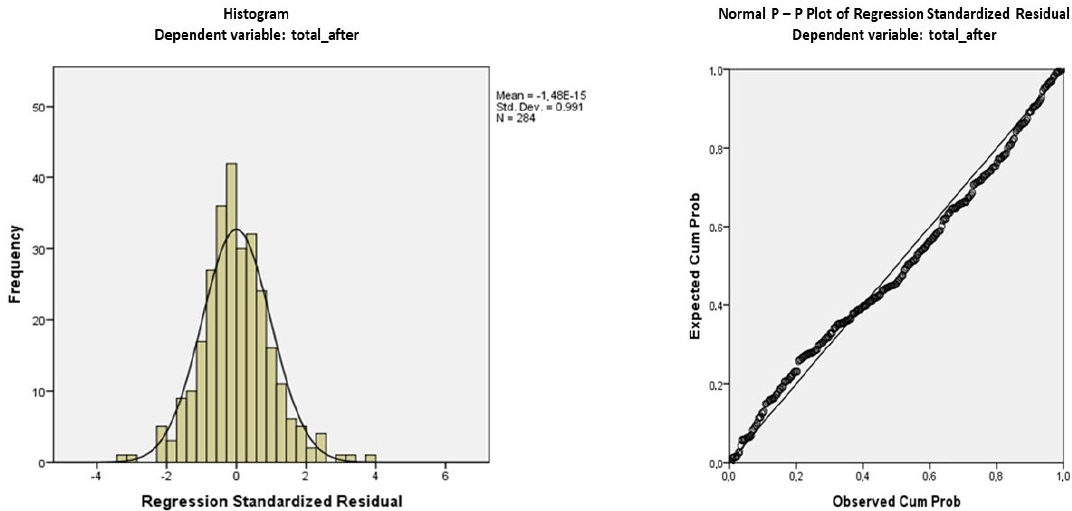
Figure 4. Histogram ( left side ) and P–P graphic of standardized residuals ( right side ). Source: own elaboration.